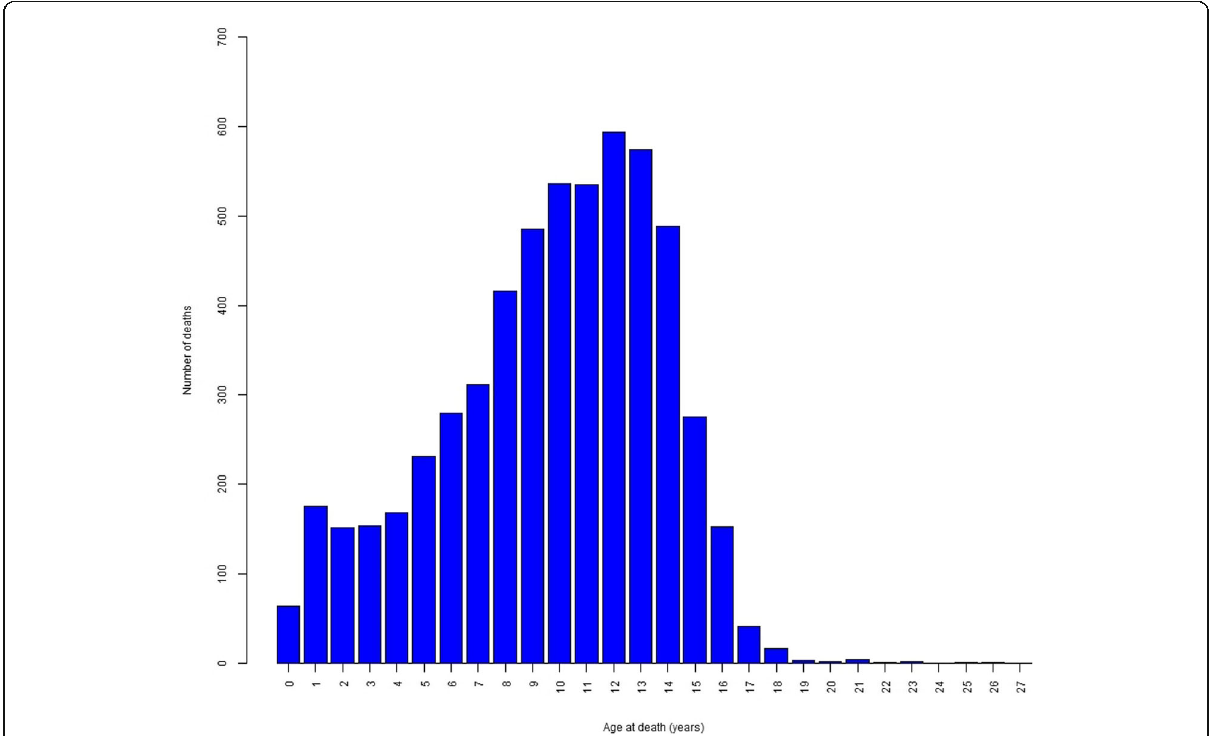
Fig. 1 Distribution of age at death from all dogs in the survey. The distribution of age at death (in years) from all dogs in the survey ( n =